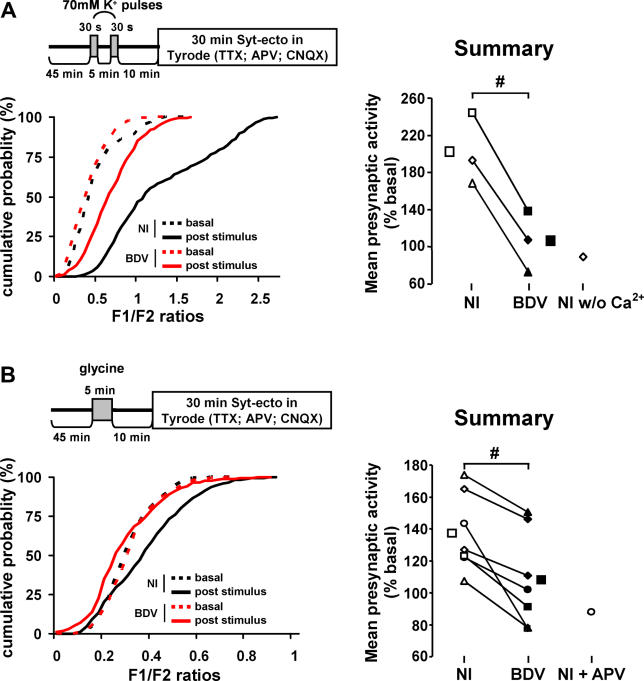
BDV Blocks Activity-Dependent Potentiation of Vesicular RecyclingCumulative probability distributions of fluorescence ratios (F1/F2) for individual synapses for the analysis of SV recycling in spontaneous conditions and after: (A) repetitive depolarization with high-K+ pulses or (B) glycine treatment. The overview of the experimental stimulation protocol is depicted above each graph. The level of SV recycling is significantly lower in BDV-infected neurons compared to NI neurons following stimulation with high-K+ pulses or glycine treatment (p < 0.001 using KS test). Note that SV recycling is even reduced after glycine treatment in BDV-infected neurons. Pairwise comparisons of mean presynaptic activities in independent experiments involved at least 300 synapses (small symbols). Bigger squares correspond to mean values of all independent experiments. Similar results were found in three to seven independent experiments. Hash mark (#) indicates p < 0.05 by paired t test.